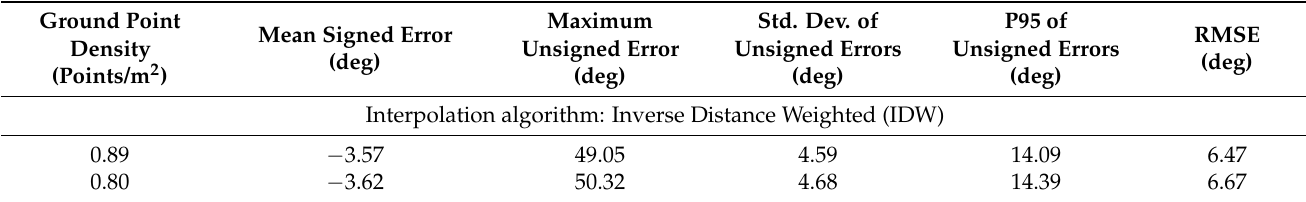
Table 2. Slope prediction accuracy at various point